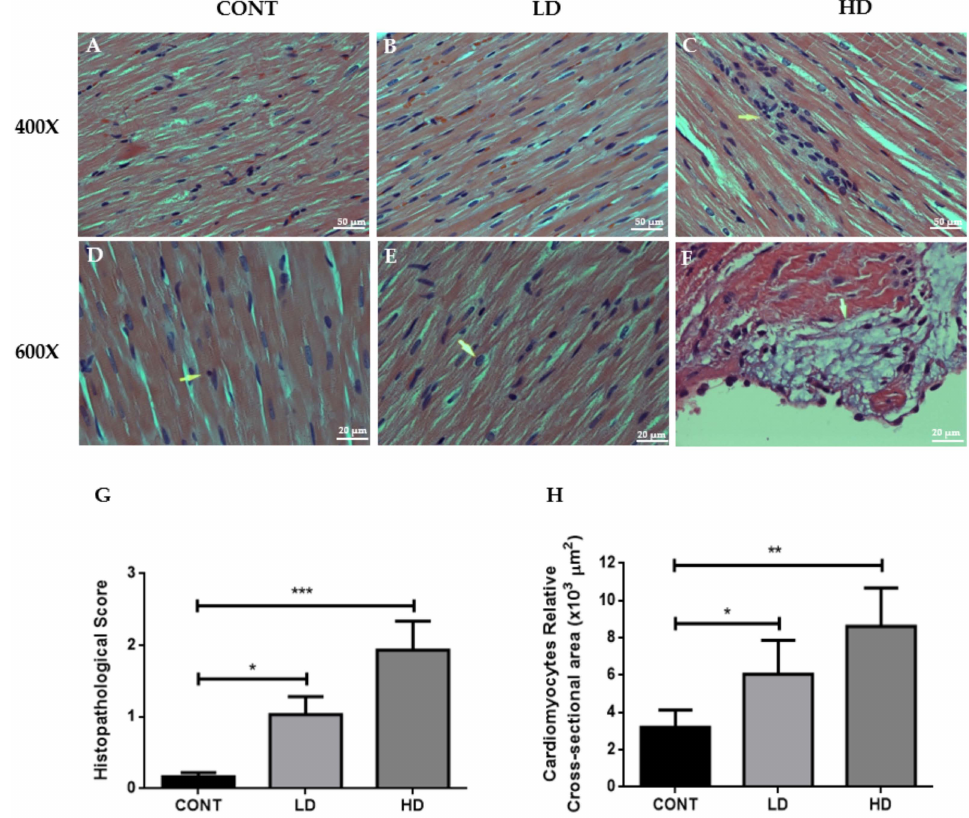
Figure 3. Light micrographs of cardiac tissues using H&E stain. ( A , D ) Represents the regular, parallel, and branching striated myocardial fibers with cross-striation and regular nuclei with no evidence of inflammation or necrosis. ( B , E ) Myocardium section obtained from low-dose VTX shows normal appearance of the myocardial fibers, but with slightly nuclear enlargement. ( C , F ) Represents heart section from rats treated with a high dose of VTX, and shows the presence of a focus of myocardial damage associated with chronic inflammatory reaction (arrowhead). Images ( A – C ) obtained at 400 × magnification, while images ( D – F ) were obtained at 600 × magnification (scale bar = 50 µ m and 20 µ m, respectively). ( G ) Histopathological score. ( H ) Cardiomyocytes’ cross-sectional area. Data are presented as mean ± SD ( n = 3). * p < 0.05, ** p < 0.01, *** p < 0.001. Cont, control; LD,